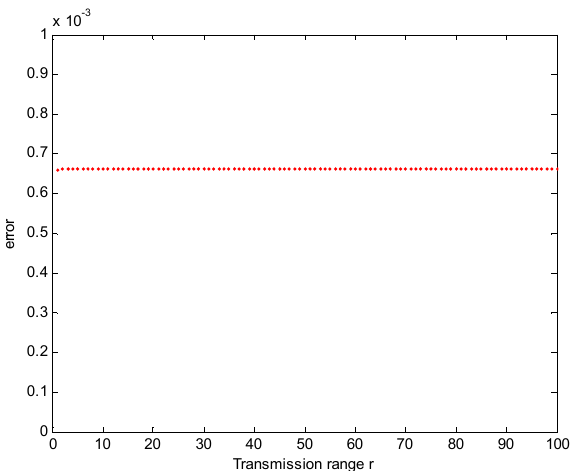
Figure 20. The error between the boundaries of energy ‐ efficiency and interference ‐ optimality.